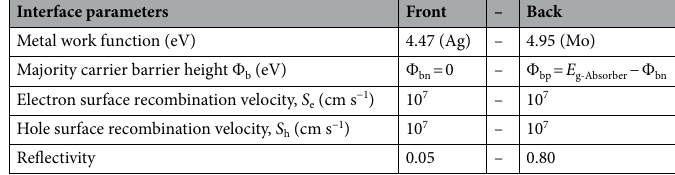
Table 2. List of physical and electronic properties for interface parameters.